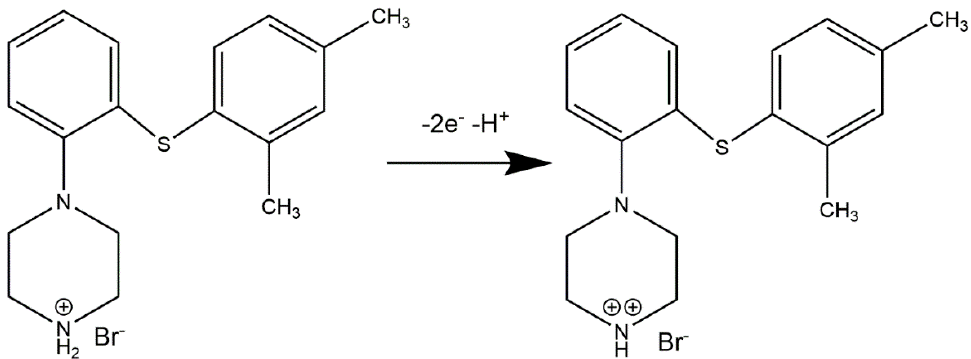
Scheme 1. Proposed mechanism of vortioxetine electrochemical